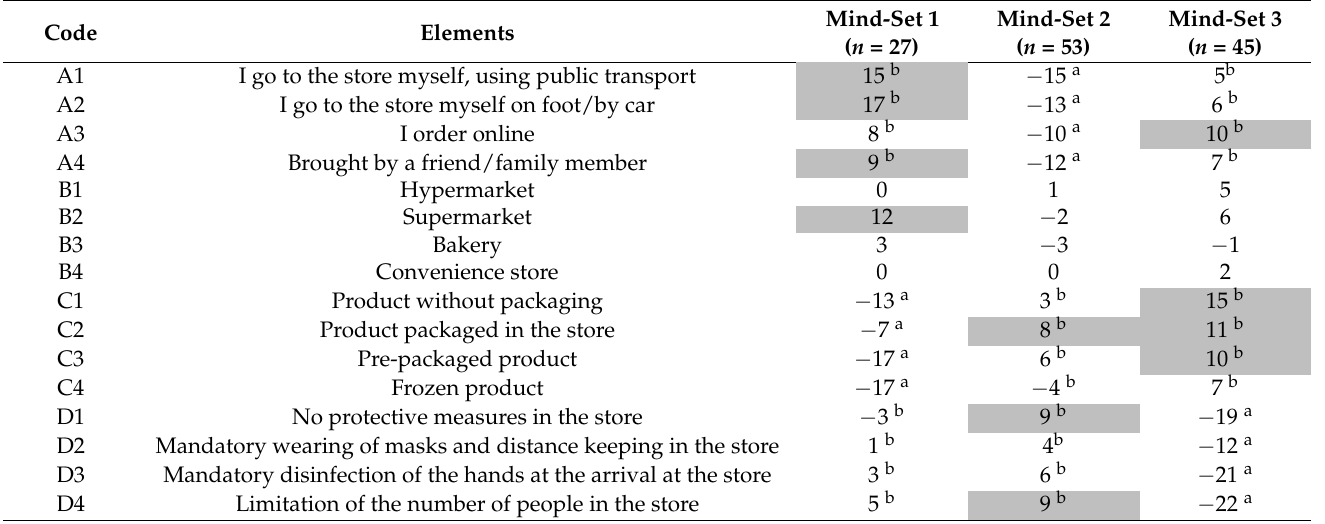
Table 4. Regression coefficients for the top scores of the three mindsets. High positive coefficients mean that respondents did feel the element safer. The highest coefficients of each group are colored as gray. Superscript letters denote the homogenous subsets defined by Tukey post hoc test ( p <